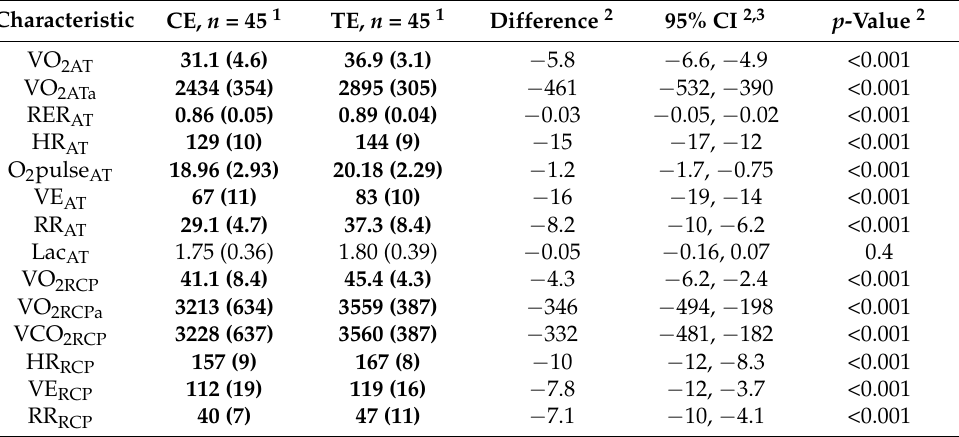
Table 6. Differences between cycle ergometry (CE) and treadmill (TE) CPET results in male partici- pants >40 years; significant results are